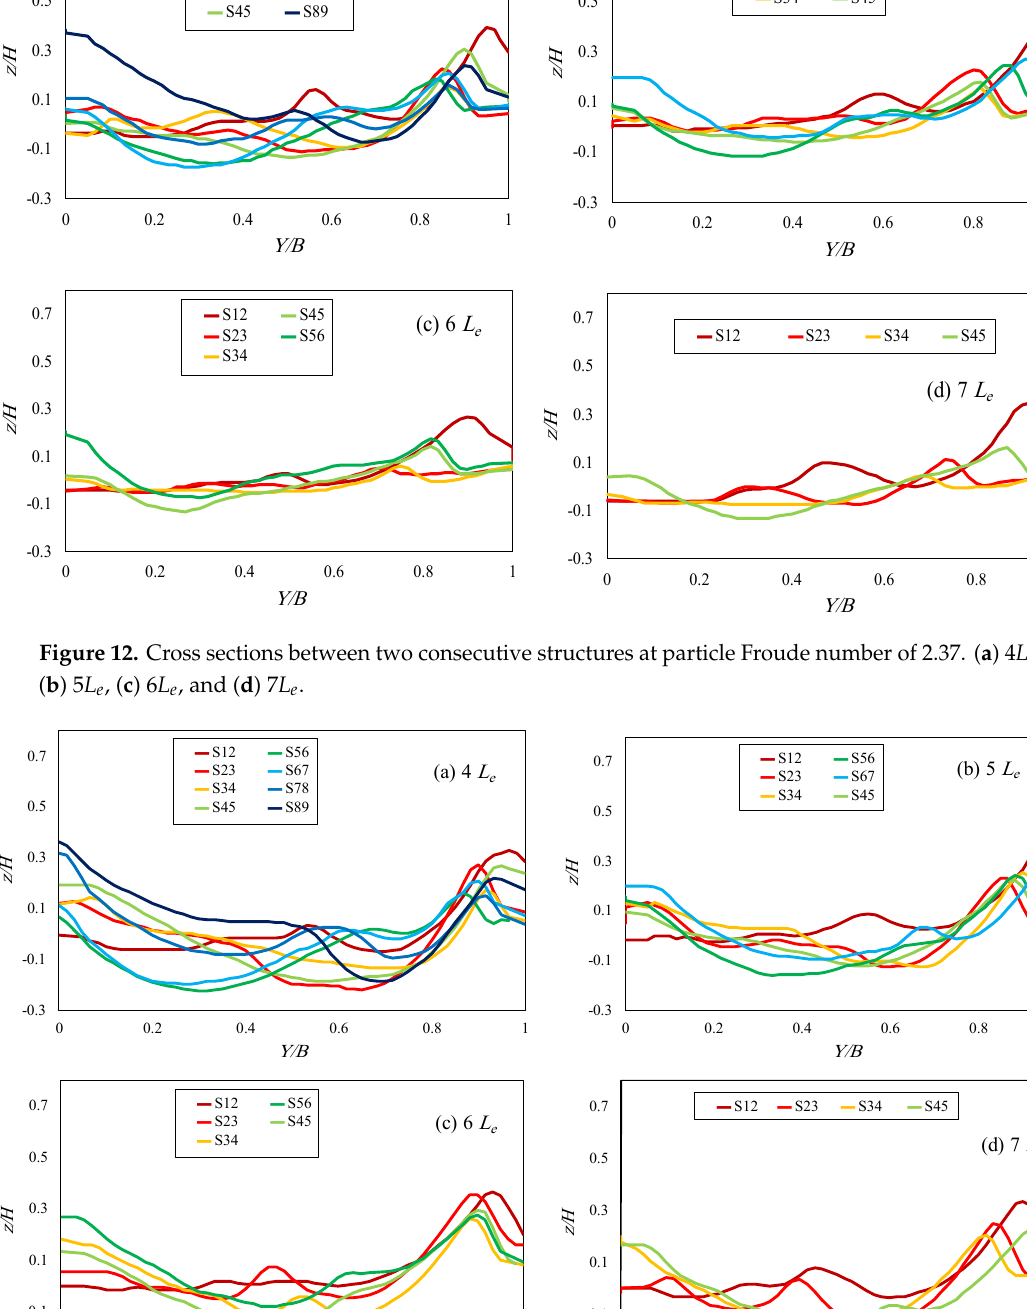
Figure 11. Cross sections between two consecutive structures at particle Froude number of 2.18. ( a )